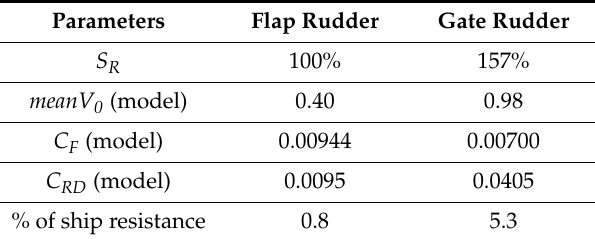
Table 2. Rudder drag calculations (in model scale).